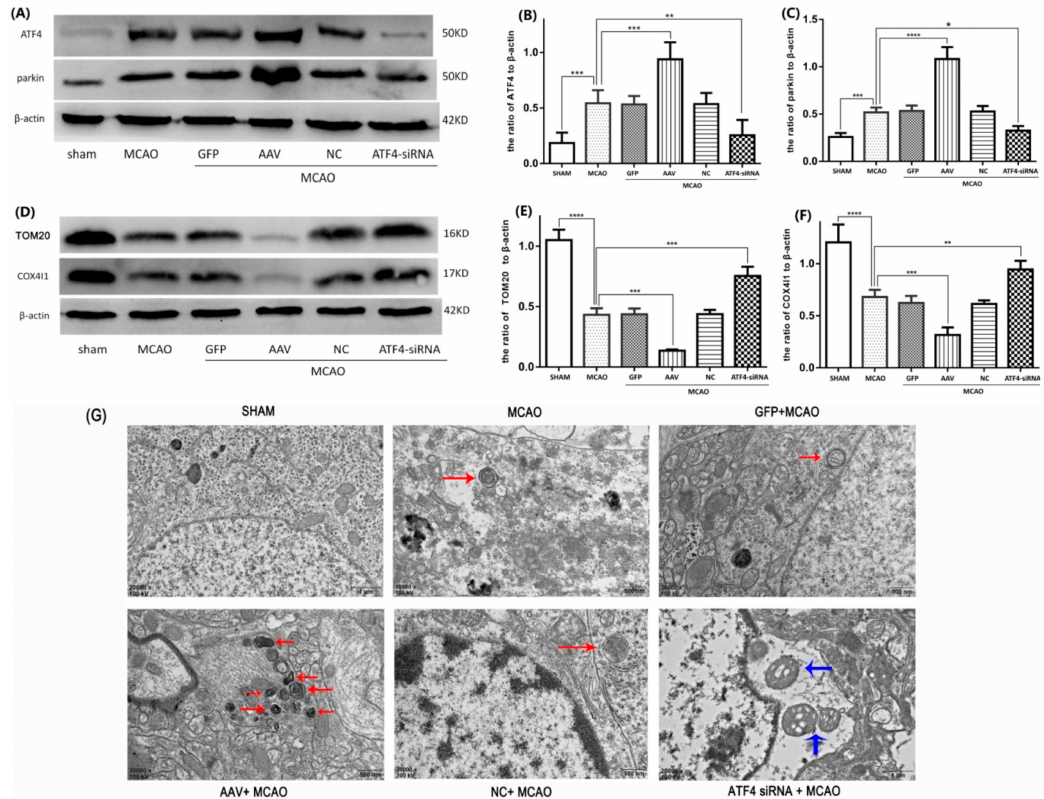
Figure 3. ATF4 increases parkin expression and mitophagy activity during cerebral I / R injury in rats. ( A – C ) Representative Western blots of ATF4 and parkin. ( D – F ) Representative Western blots of TOM20 and COX4I1. Protein levels were normalized to β -actin. ( G ) The representative ultrastructures of mitophagy are shown: the structures of mitochondrials and nucleus were normal in the sham group; a few mitochondria engulfed by a double-membrane structure are labeled by red arrows in the MCAO, GFP + MCAO and NC + MCAO groups; many autophagic vesicles, which encapsulated with mitochondrias and were fused with lysosomal, were labeled by red arrows in the AAV + MCAO group; in the ATF4-siRNA + MCAO group, swollen mitochondrias were labeled by blue arrows and the typical autophagic vesicle was hardly observed. Error bars represent mean ± SD. (* p < 0.05, ** p < 0.01, *** p < 0.001 and **** p < 0.0001 vs. indicated group). n = 5 in each group. MCAO, middle cerebral artery occlusion-reperfusion; GFP, green fluorescent protein; AAV, ATF4 overexpression adeno-associated virus; siRNA, small interfering RNA; NC, negative control